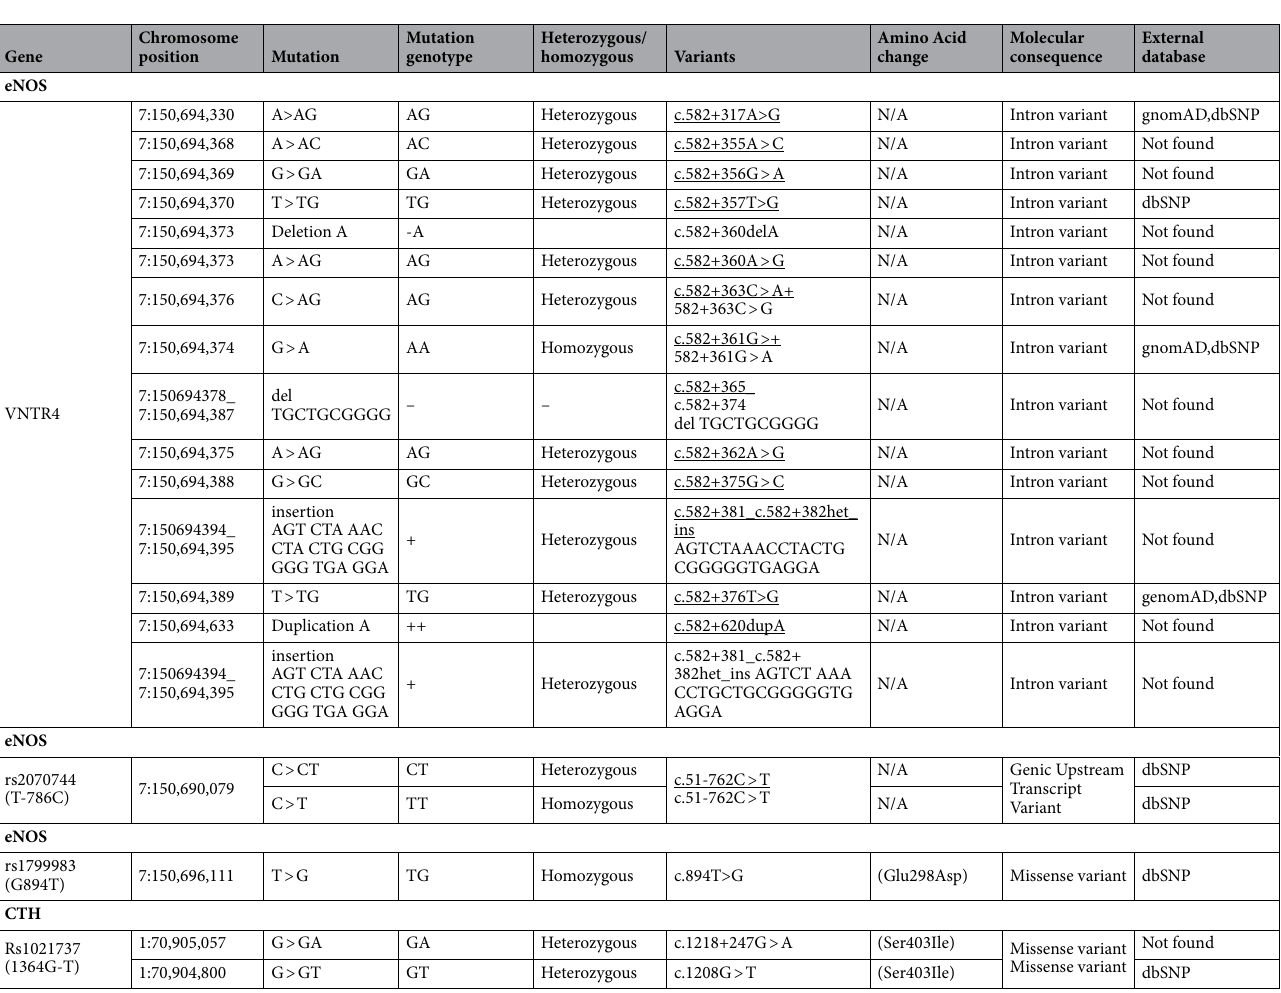
Table 1. Variants identified in CRC patients analyzed with mutation DNA variant